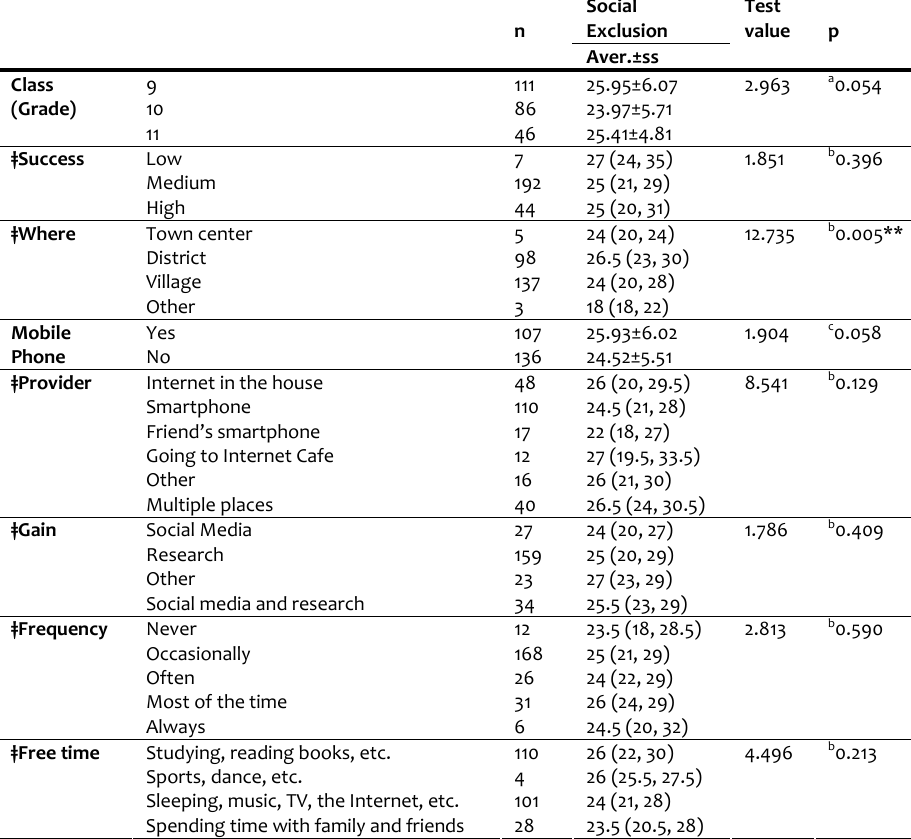
Table 3. Assessments by Social